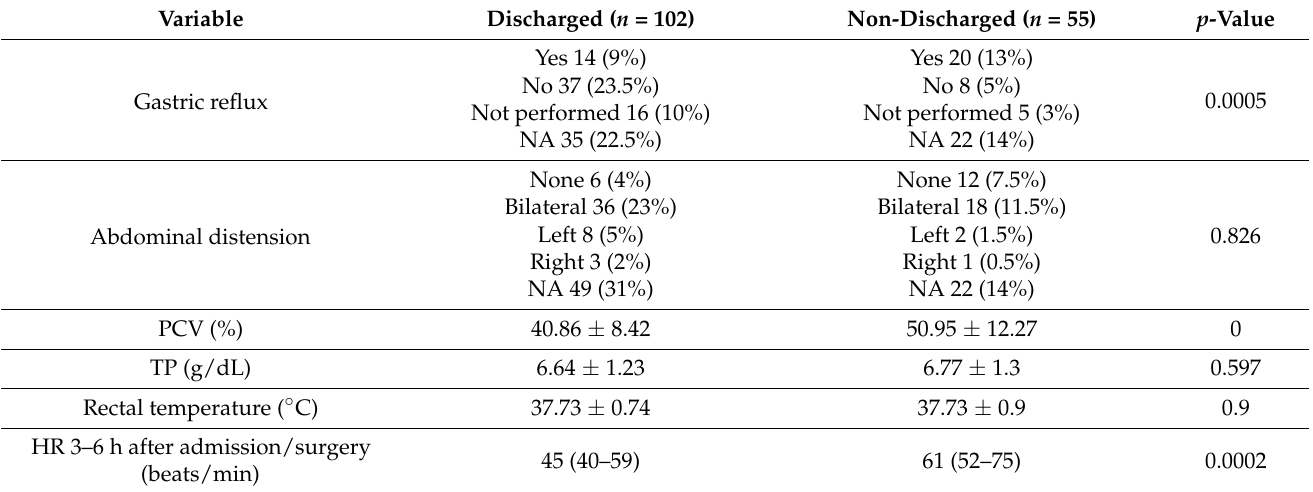
Table 4. Univariate logistic regression model showing the association between the explanatory vari- ables and the outcome (=non-discharge) in 157 horses admitted for colic syndrome at the